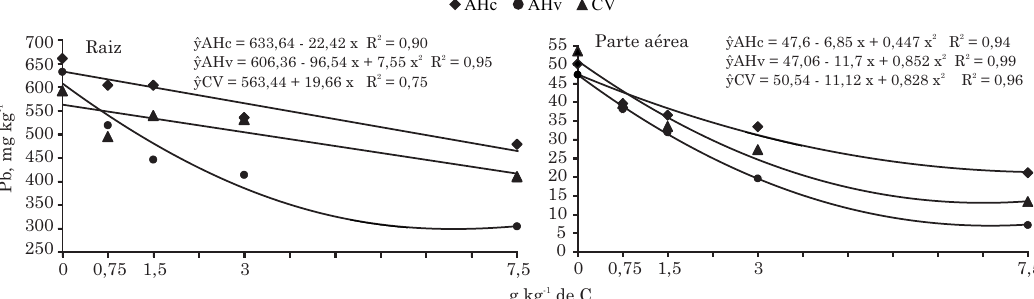
Figura 2. Teores de chumbo na raiz e na parte aérea de milho em função de doses de carbono aplicadas ao solo via ácidos húmicos comerciais (AHc), ácidos húmicos extraídos de vermicomposto (AHv) e carvão vegetal ativado